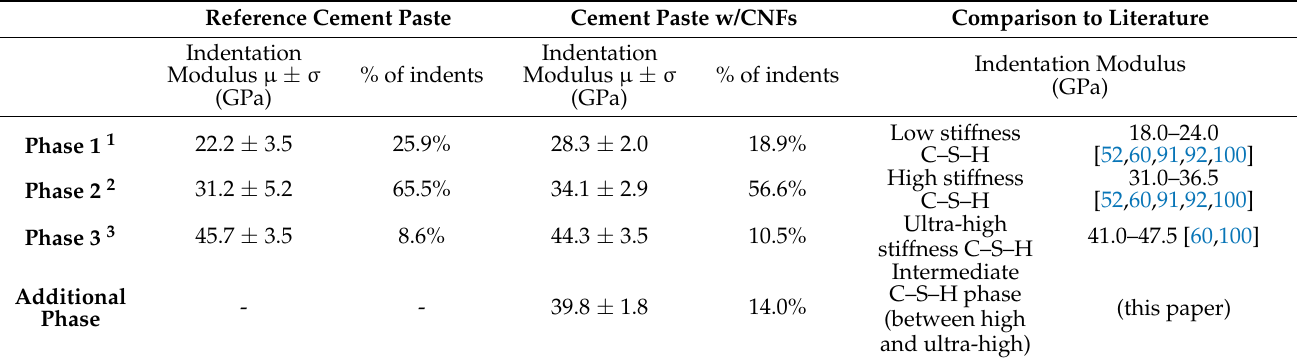
Table 3. Output from the Gaussian fitting algorithm for the 0–50 GPa indentation modulus range of the phases typically associated with C–S–H phases for the reference cement paste and cement paste with